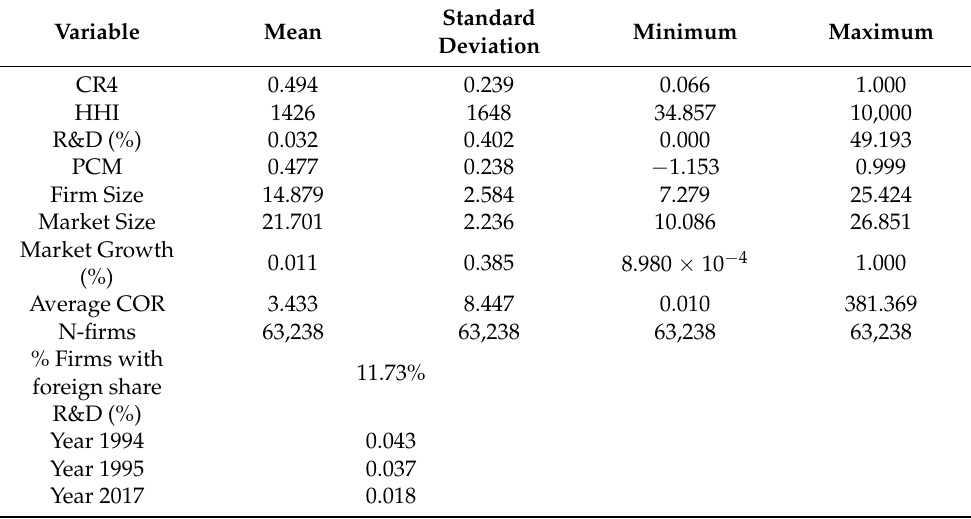
Table 1. Descriptive statistics of the